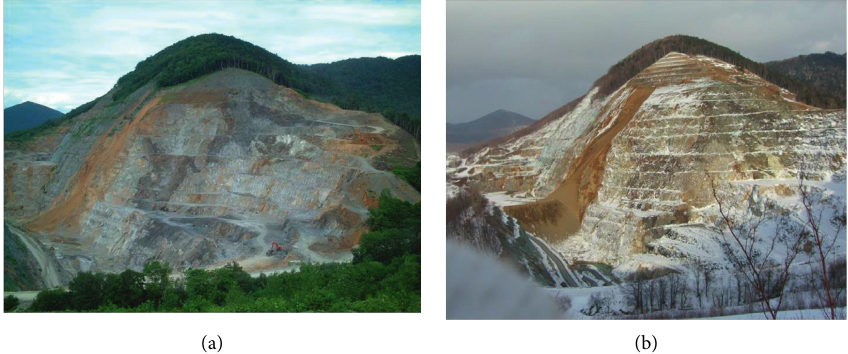
Figure 5: Layout of the rock slope (a) before and (b) after cutting upper part of the slope in July, 2004 and November, 2009.